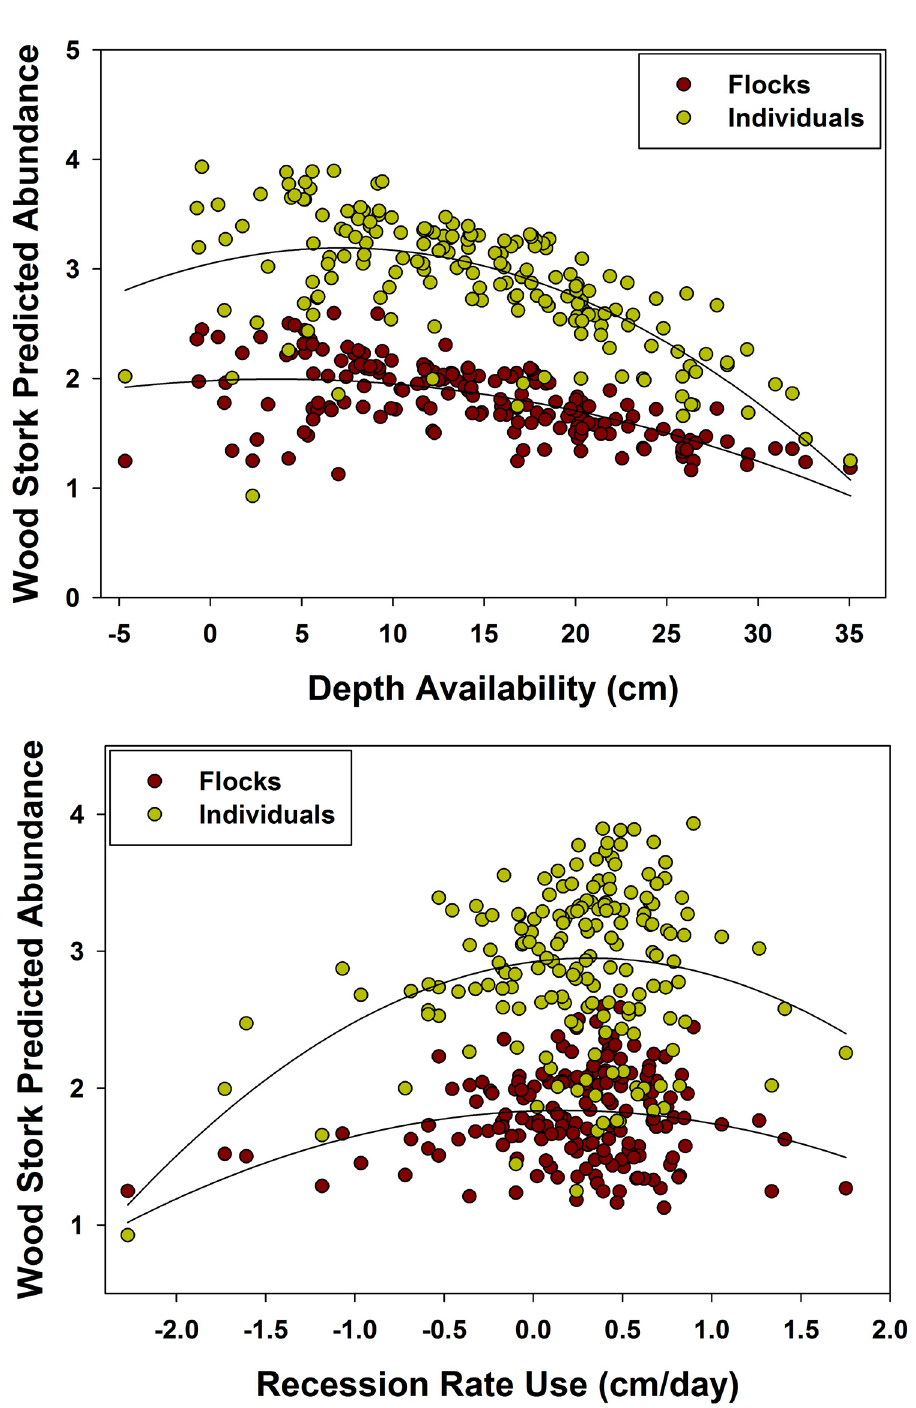
Fig 4. Daily mean landscape flocks and individuals (fourth-root transformed) predicted by the model- averaged terms for the Wood Stork. Predicted presence and abundance are highest with an average landscape depth (within available depths) less than 15 cm and when Wood Storks are using an average recession rate of ~0.5 cm/day.